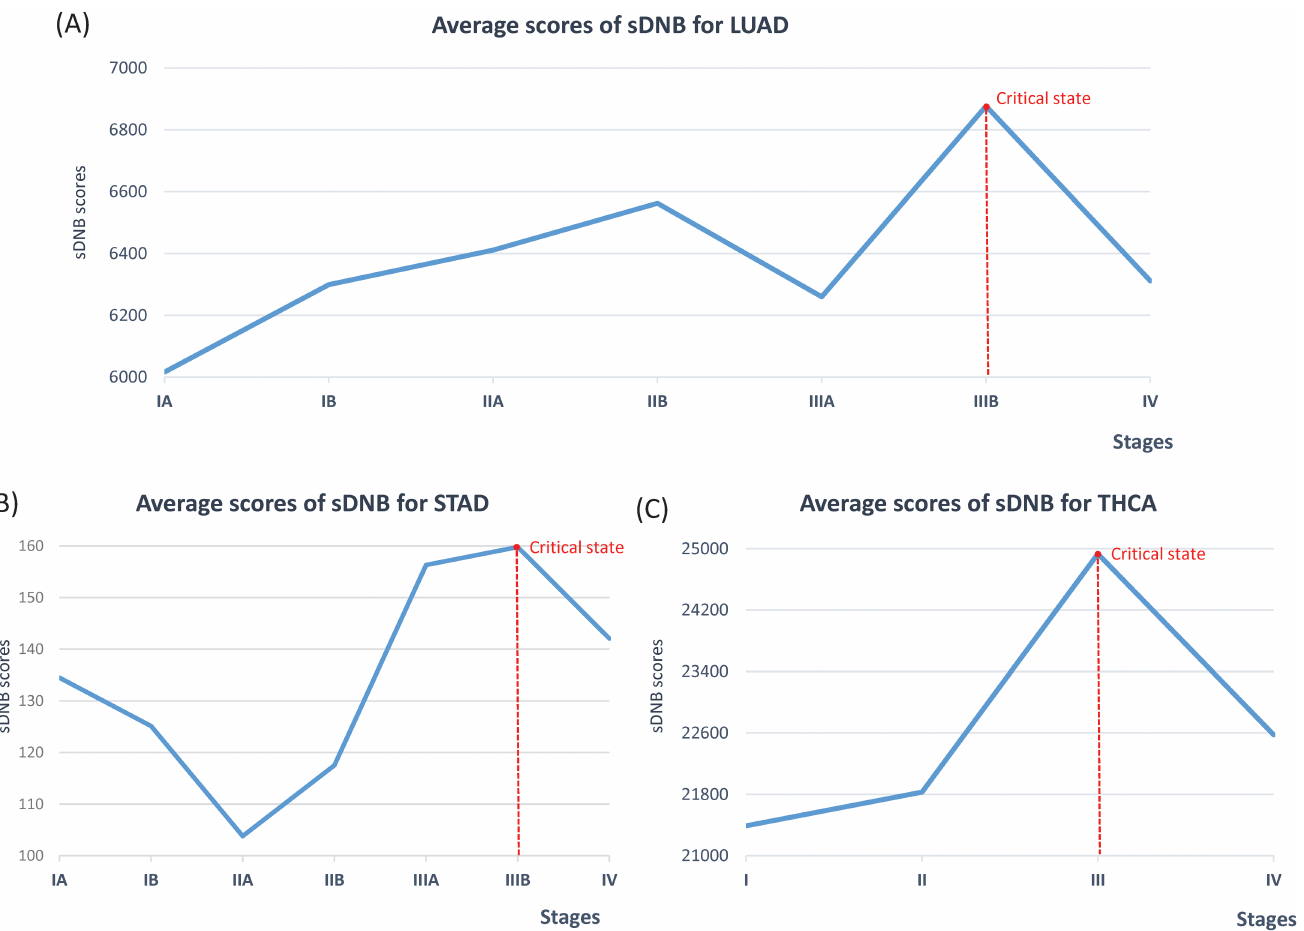
Fig 4. Quantifyingthe critical states for metastasis in three cancers: (A) LUAD, (B) STAD, and (C) THCA.